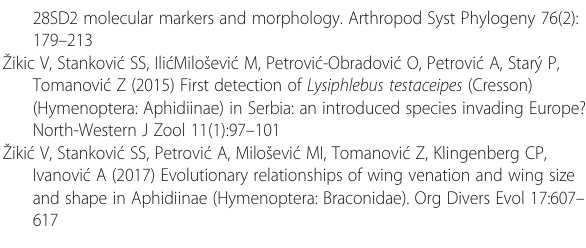
28SD2 molecular markers and morphology. Arthropod Syst Phylogeny 76(2): 179 –